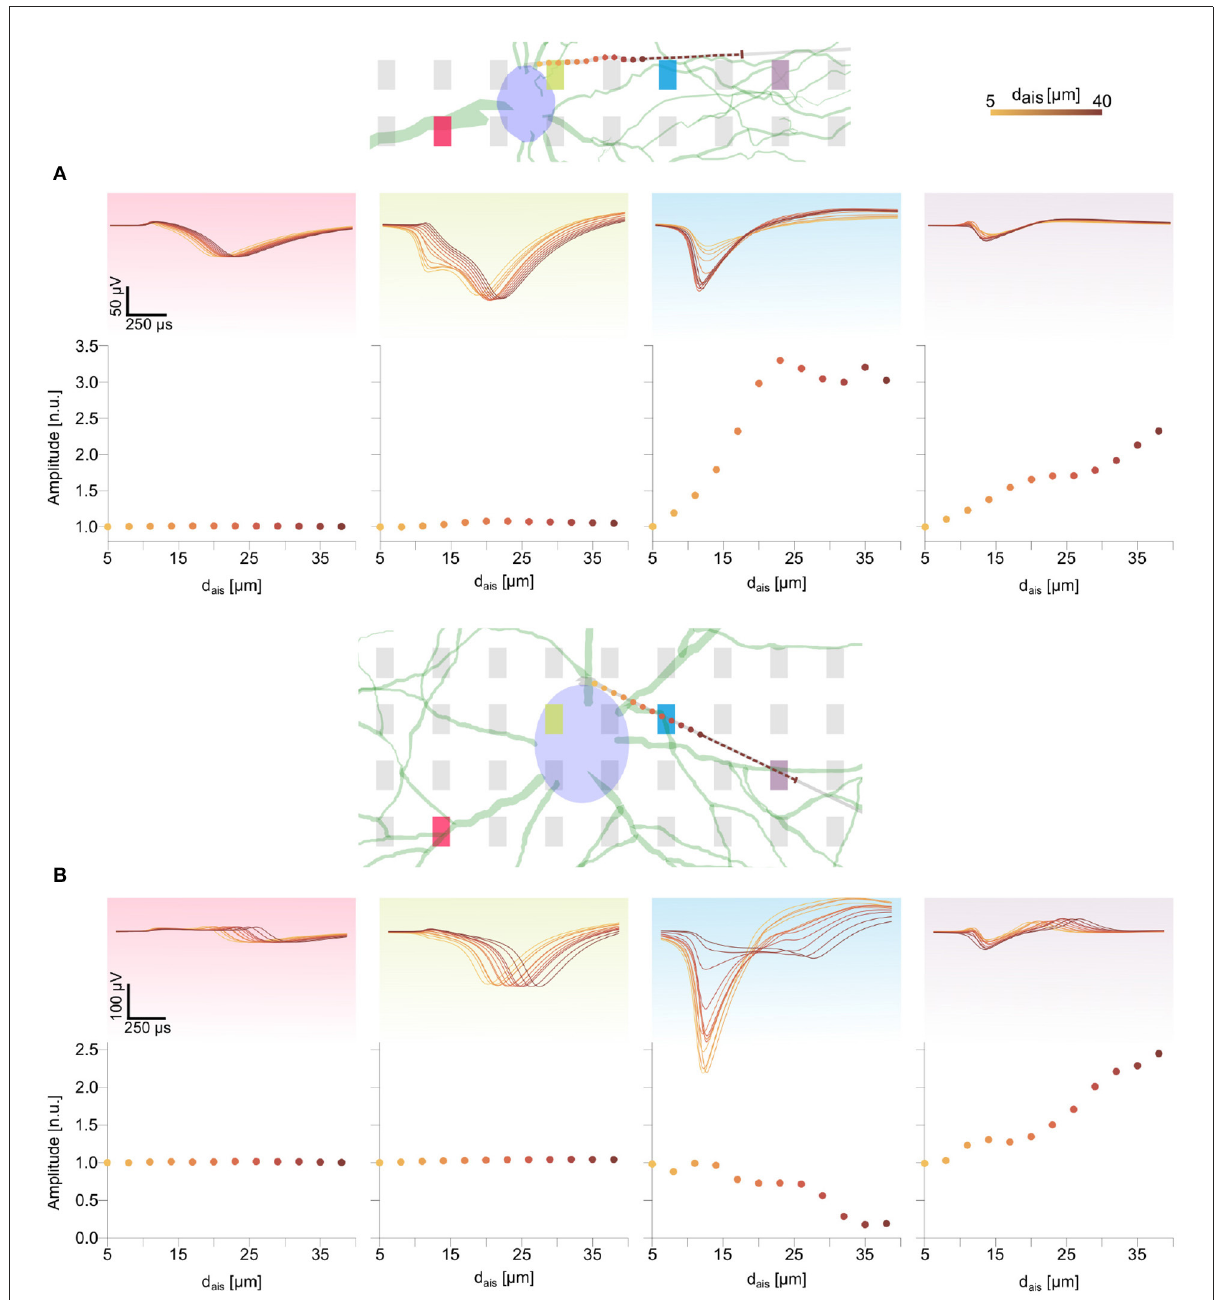
FIGURE4 Changes in spike waveform features for the two detailed morphology models were qualitatively similar to those observed in the ball-and-stick model (Figure 3). The AIS locations are marked as colored dots along the axon (see text footnote 4 ). The dashed line illustrates the 30 µ m long AIS, starting from the last position. Normalized extracellular amplitudes are shown in the bottom rows of (A,B) . Movement of the AIS away from an electrode along the axon led to extracellular amplitude attenuation [e.g., blue electrode and panel in (B) ], whereas amplitudes increased for electrodes in the direction of the AIS relocation [e.g., purple electrode and panel in (B) ].